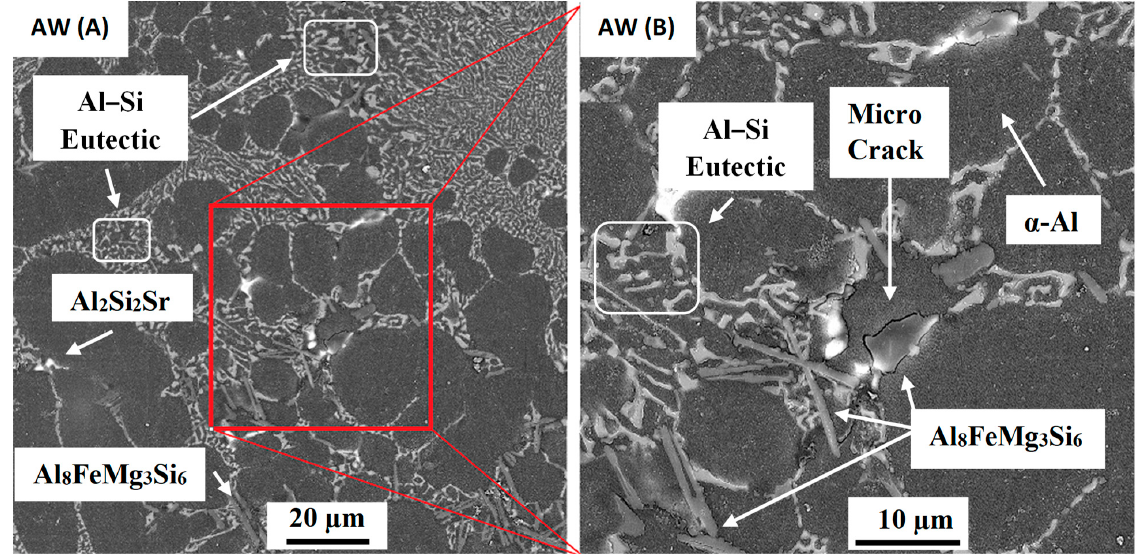
Figure 5. Micrographs for the as-cast component showing: ( A ) AW location; ( B ) close-up of the red box region in ( A ) showing various phases. Table 3. Summary of the average volume fraction for various phases of interest in the as-cast com-